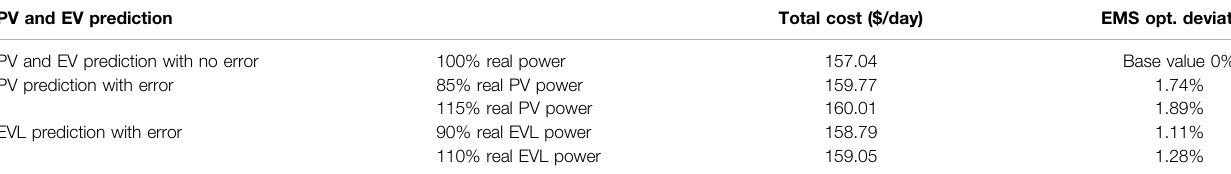
TABLE 5 | Operation cost of station under photovoltaic (PV) and electric vehicle load (EVL) prediction error. PV and EV